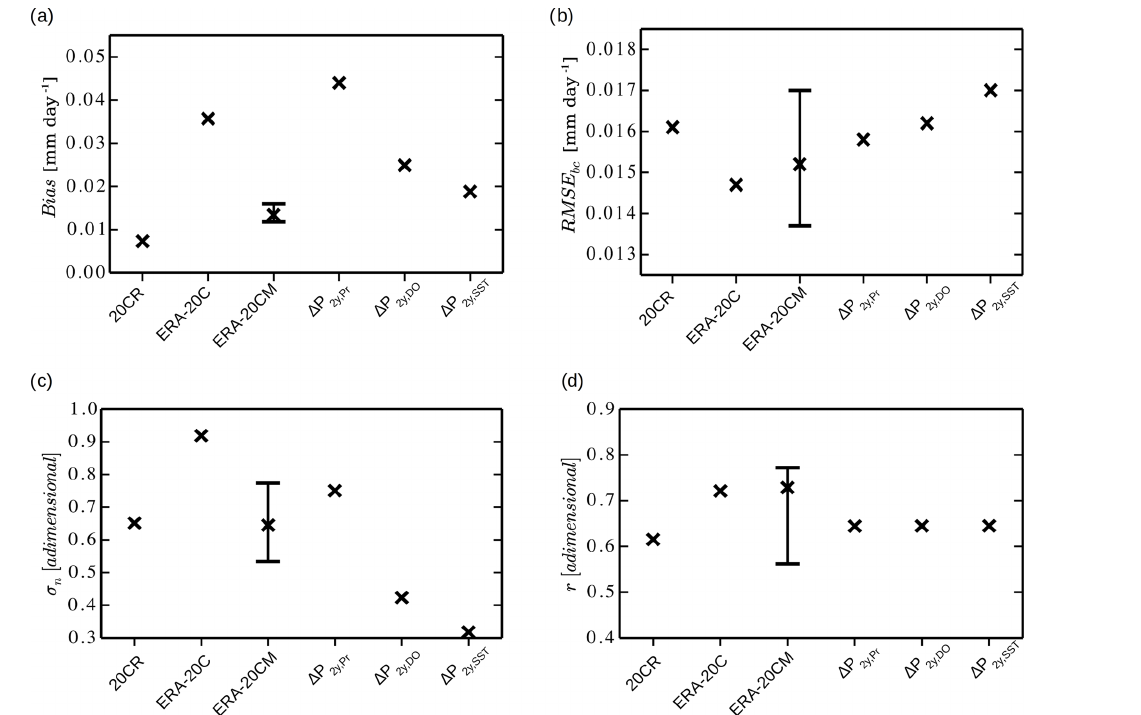
Figure 4. Error estimates from simulated anomaly time series for P at 2-year resolution against GPCP computed for the 1979–2010 period, including (a) mean bias (Bias), (b) root mean square error after bias correction (RMSEbc), (c) model standard deviation normalized by observed standard deviation ( σ n ), and (d) Pearson correlation coefficient ( r ). For the ERA-20CM dataset the range for all ensemble members is shown, while “ x ” marks their mean value. The p value for all correlations shown in (d) is < 0 . 05.